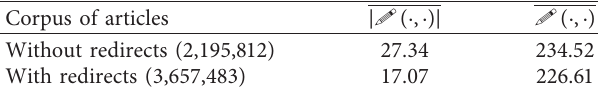
Table 4: Estimates of the average number of active authors per Wikipedia article ( � |(· , ·)| ) and the average activity of authors per article ( � (· , ·) ) differentiated for the complete set of articles in the German Wikipedia (downloaded at 2018-07-01) with and without redirect articles (numbers of articles in